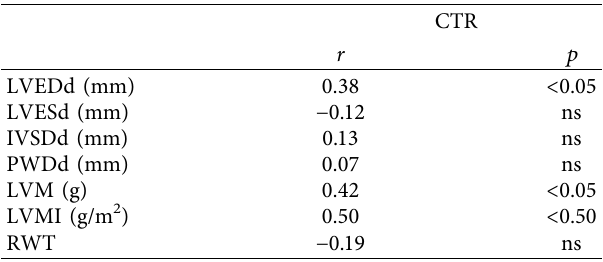
Table 5: Correlation of the cardiothoracic ratio in the chest ra- diograph and the size of the left ventricular in the echocardiography.